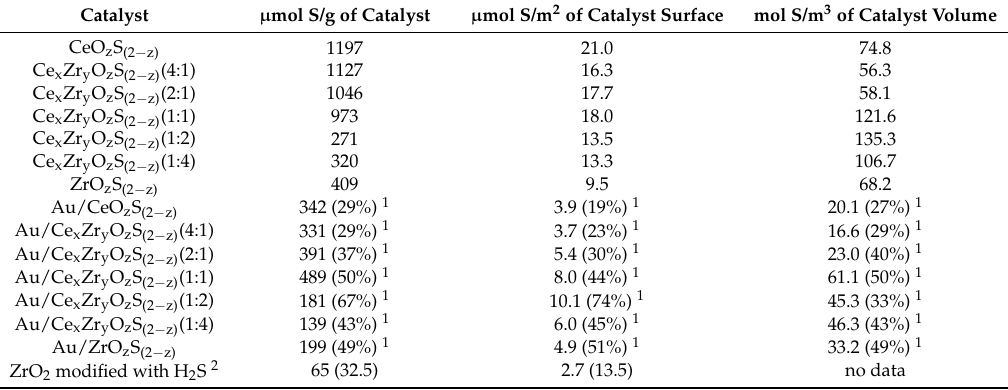
Table 3. The influence of texture parameters on sulfur species content in samples.